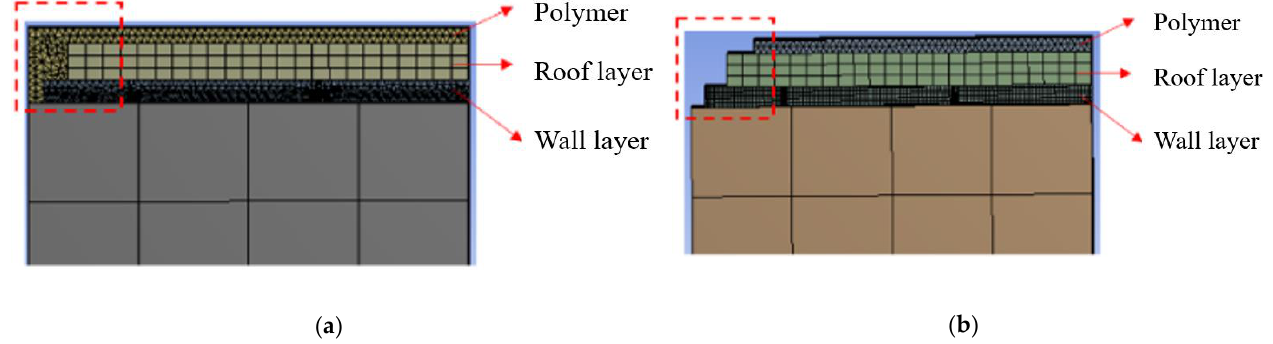
Figure 9. Structural comparison of ( a ) top-side molded WLP with ( b ) typical fan in SAW device package.